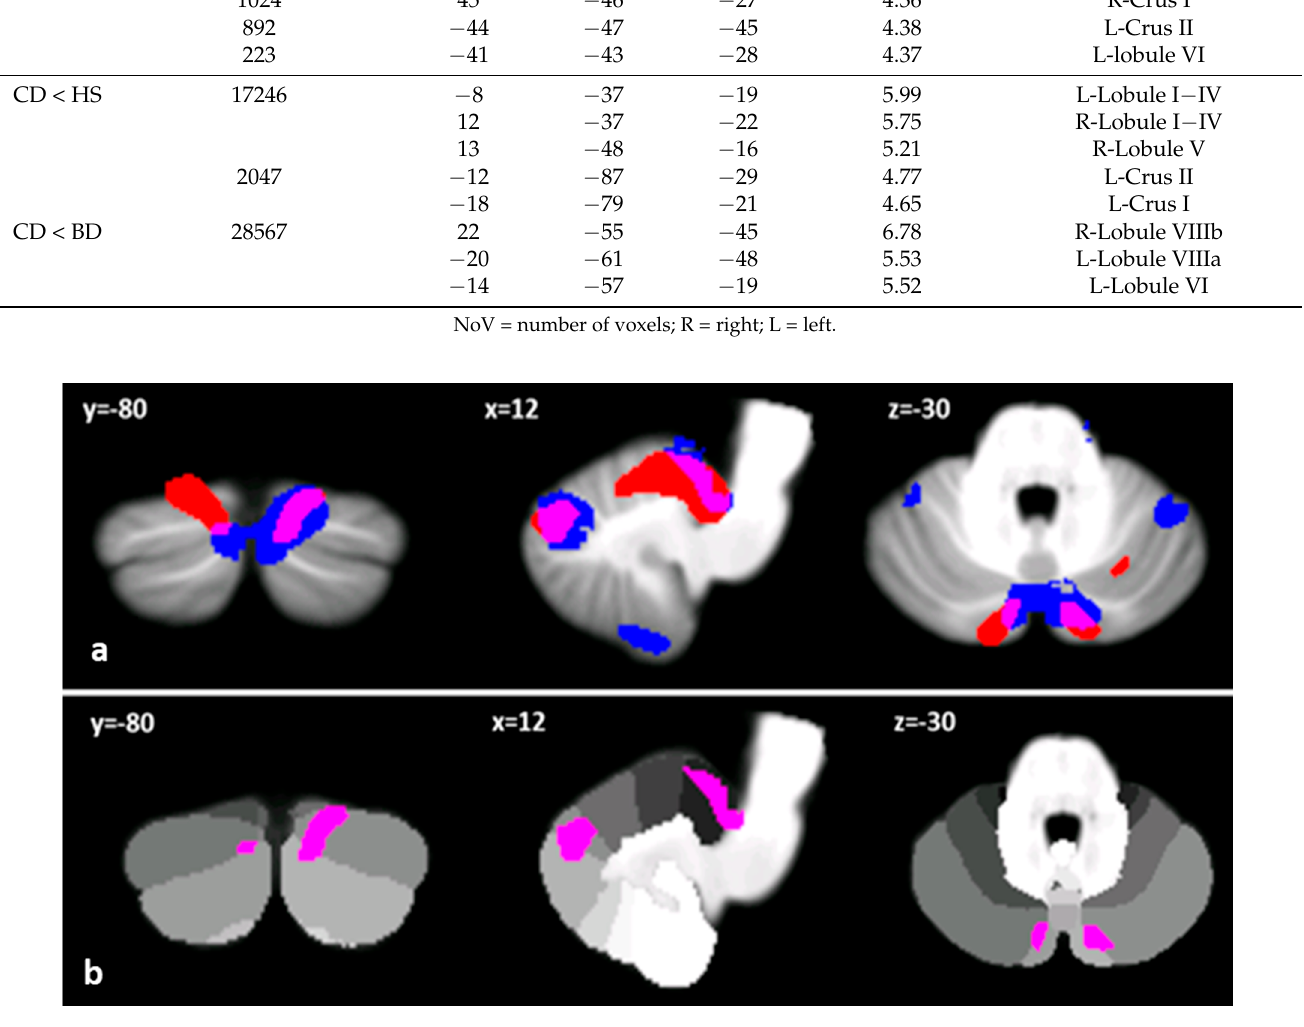
Figure 2. ( a ) Clusters of reduced cerebellar GM in BD and CD compared to HSs are reported in blue and red, respectively. Regions of overlapped cerebellar GM loss between BD and CD are shown in violet on the spatially unbiased infratentorial template (SUIT) [51]. ( b ) Only cerebellar regions showing patterns of significantly reduced GM in both BD and CD patients are shown in violet and superimposed on the probabilistic SUIT cerebellar atlas [51], which provides anatomical subdivision of cerebellar lobules (in greyscale). Images are shown according to radiological convention in coronal (y), axial (z) and sagittal (x)